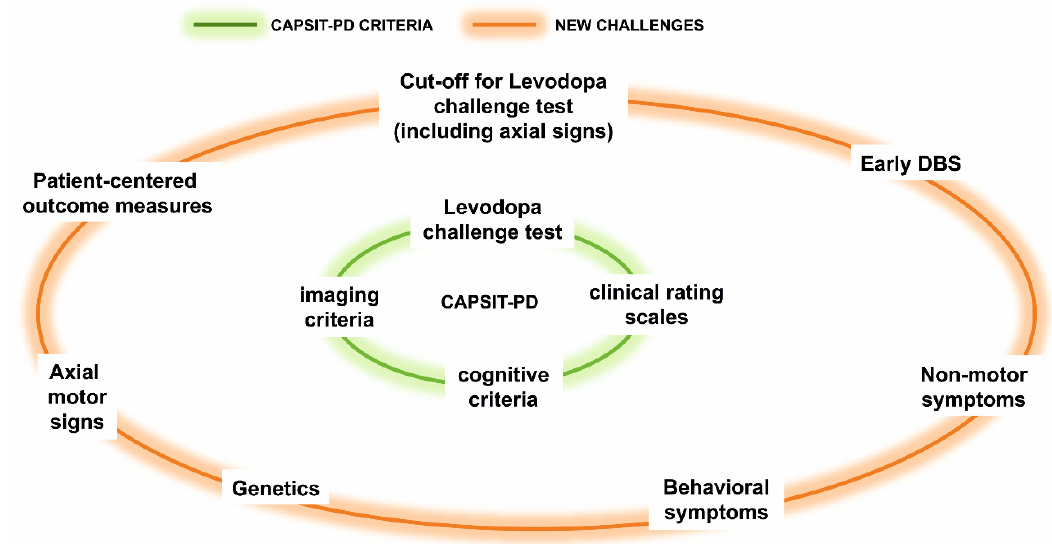
Figure 1. Core Assessment Program for Surgical Interventional Therapies in Parkinson’s Disease (CAPSIT-PD) and recommendations on challenging areas related to the deep brain stimulation (DBS)